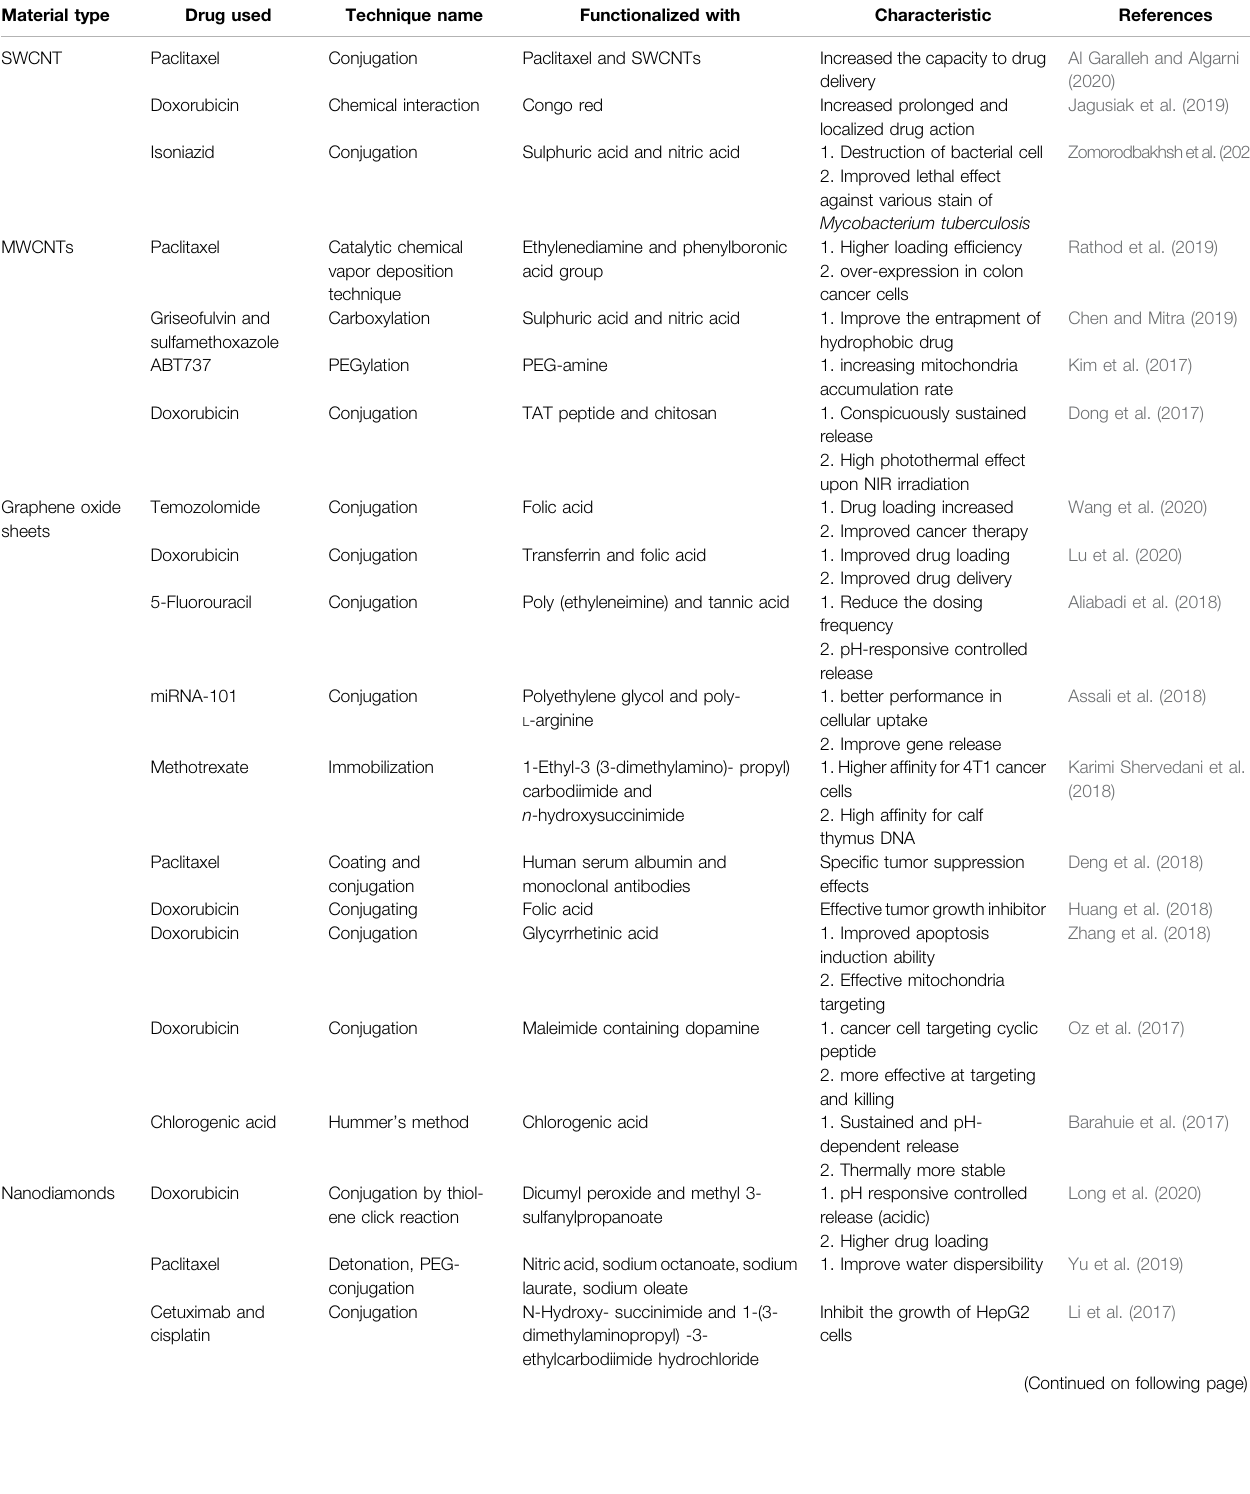
TABLE 1 | Recent application of functionalized carbon-based materials for drug